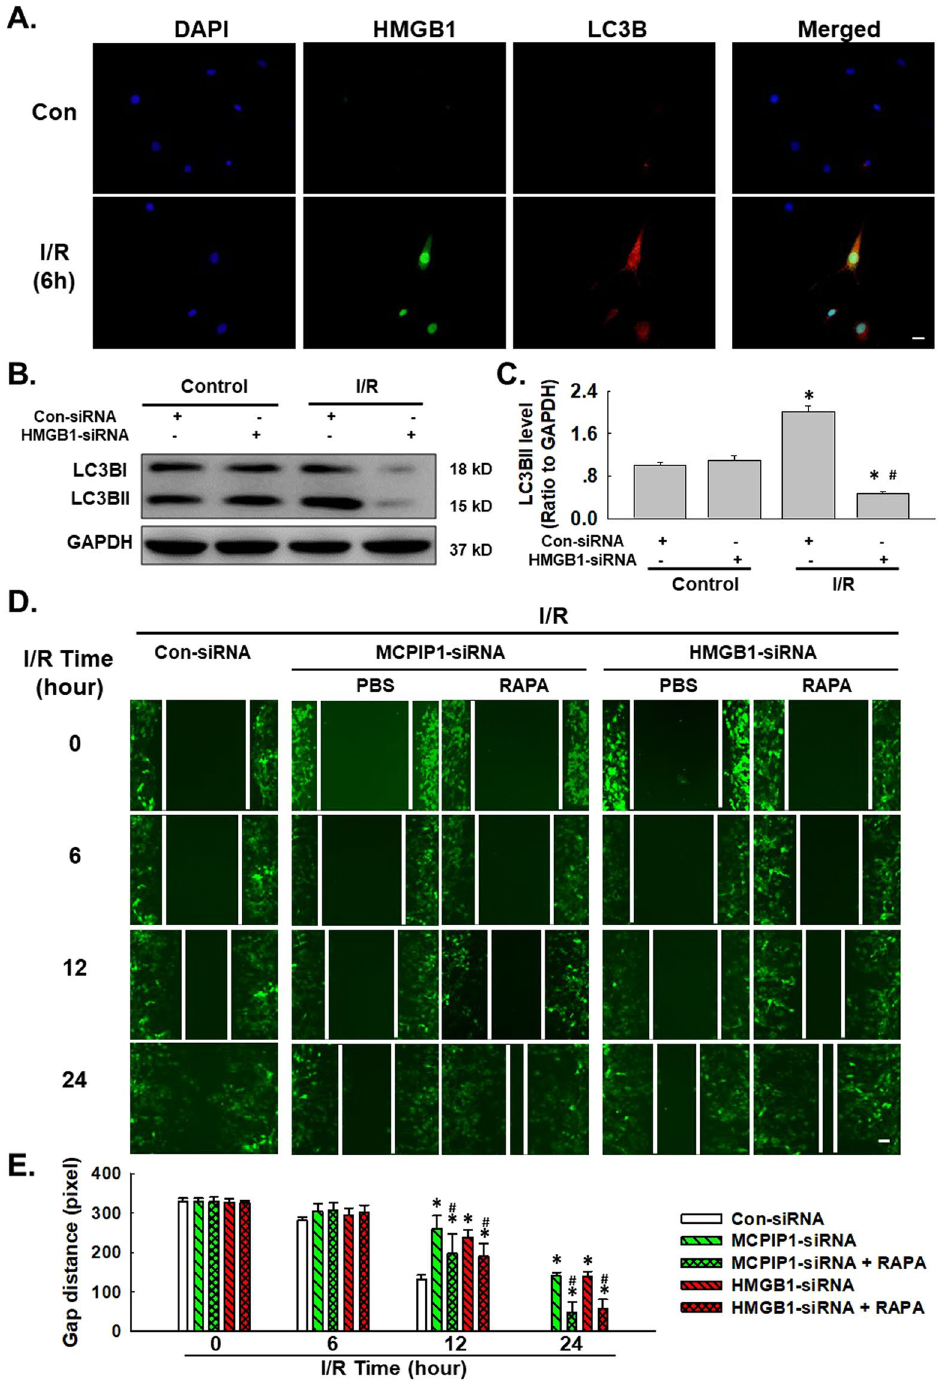
Figure 3. Autophagy mediated the effect of HMGB1 on I/R-induced cell migration. ( A ) Representative images of immunocytochemical staining showing that HMGB1 co-localized with the autophagy marker LC3B in HUVECs in response to I/R injury. Scale bar, 20 μ m. ( B ) Representative blots showing that HMGB1 siRNA attenuated the I/R-induced increase in LC3B expression. ( C ) Densitometric analyses of LC3B levels from four independent experiments; * p < 0.05 compared with the control group, # p < 0.05 compared with the I/R group. ( D ) Representative images depicting that the inhibitory effects of HMGB1 and MCPIP1 siRNAs on I/R-induced cell migration were reversed by pretreatment with rapamycin (1 μ mol/L, 1 hour). Scale bar, 80 μ m. ( E ) The quantification of the scratch gap distance in six independent experiments is presented. * p < 0.05 compared with the corresponding time point in the control group, # p < 0.05 compared with the corresponding time point in the I/R